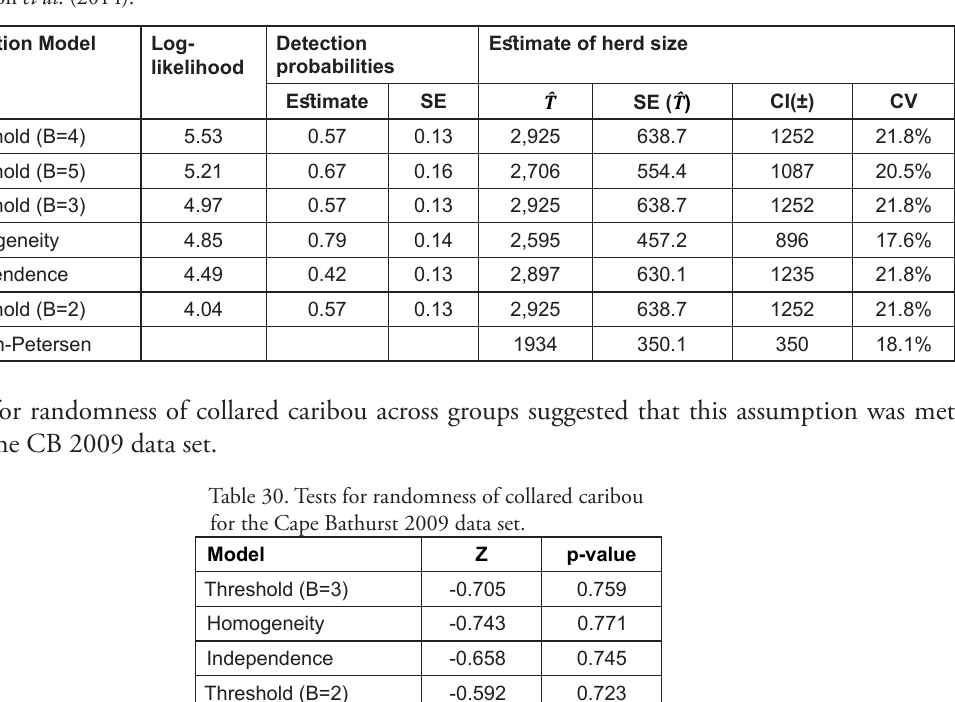
Rivest model analysis suggested that a threshold model with detection probabilities of 1 for groups with 5 or more collars was most supported. Groups with less than 4 collars had a detection prob- ability of 0.57. This model produced an estimate of 2,925 caribou compared to an estimate of 1,934 caribou from the Lincoln-Petersen estimator. Estimates had marginal precision (CV>20%). Table 29. Rivest estimator results for the Cape Bathurst 2009 data set. The Lincoln-Petersen estimate is based on Davison et al . (2014).